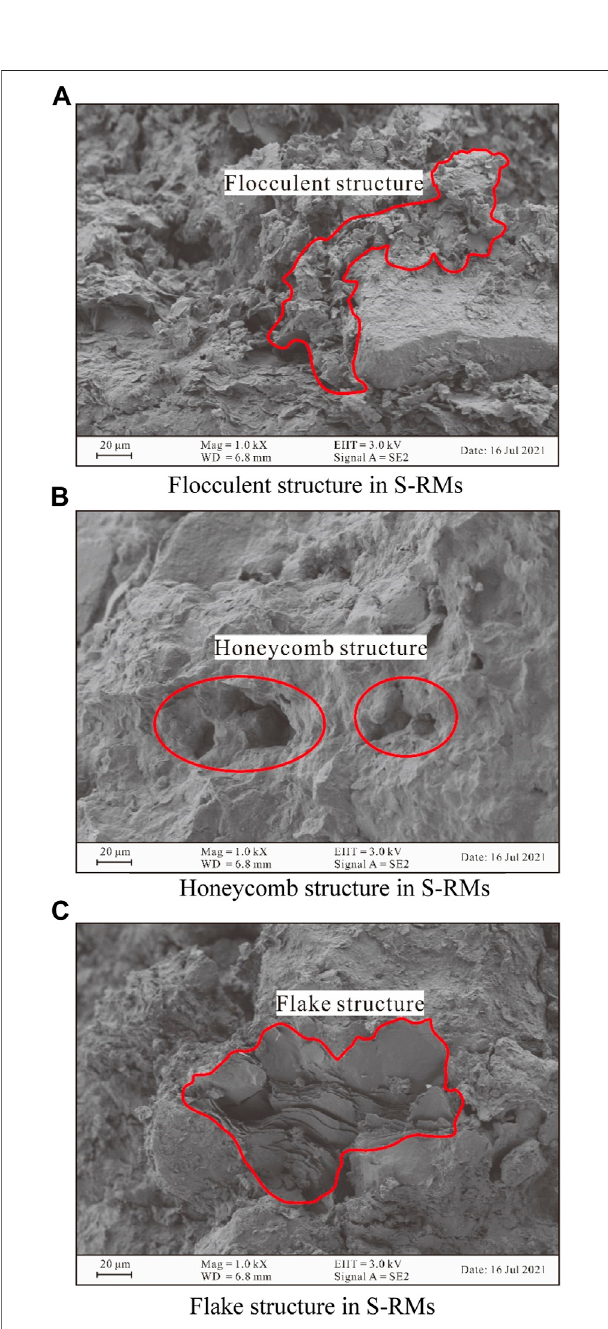
FIGURE 10| Microstructure ofsoil-rock mixture: (A) fl occulentstructure in S-RMs; (B) honeycomb structure in S-RMs; (C) fl ake structure in